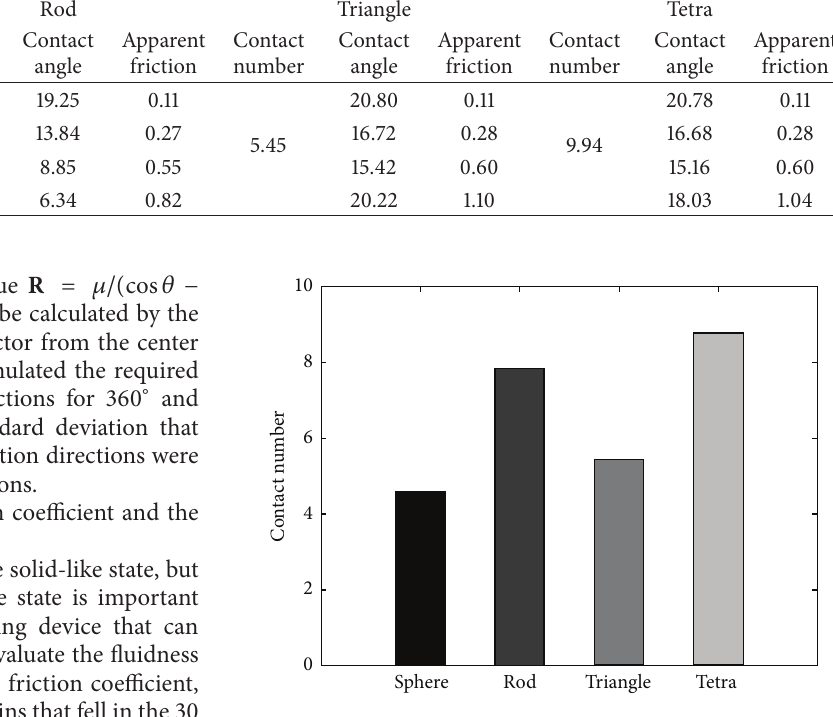
Figure 5: Average number of contacts.